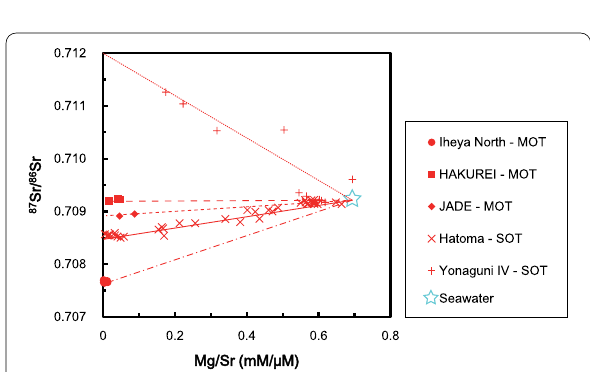
Fig. 3 Relationship between Mg/Sr and 87 Sr/ 86 Sr in hydrothermal fluids from the Iheya North Knoll, HAKUREI, JADE, Hatoma Knoll, and Yonaguni Knoll IV sites in the Okinawa Trough. For an explanation of insets, refer to Fig. 2